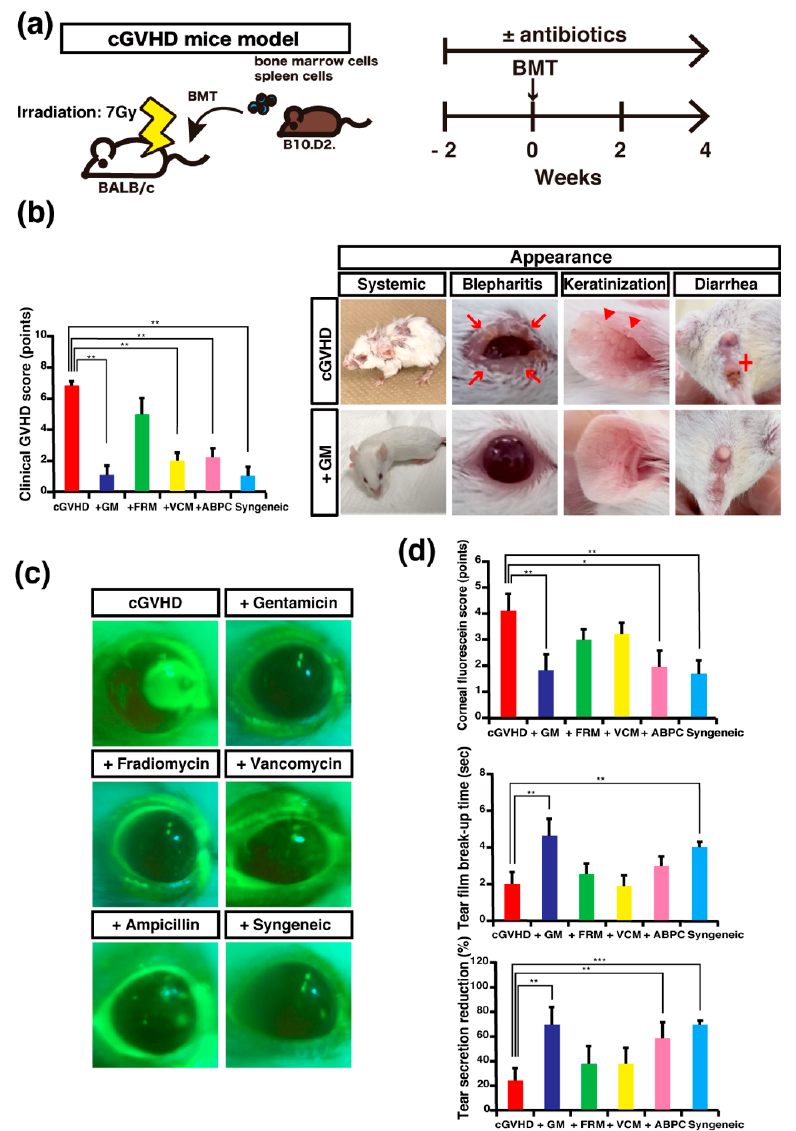
Figure 1. Systemic and ocular clinical phenotypes of antibiotic-treated chronic graft-versus-host disease (cGVHD) mice: ( A ) scheme of allogeneic bone marrow transplantation (BMT), and the experimental treatment protocol using antibiotics; ( B ) clinical GVHD scores of cGVHD mice treated with antibiotics, non-treated control mice, and syngeneic control mice (left) ( n = 5 per group). GM, gentamicin; FRM, fradiomycin; VCM, vancomycin; ABPC, ampicillin. Data are presented as mean ± SEM. * p <0.05, unpaired Student’s t -test for non-treated cGVHD mice versus antibiotic-treated or syngeneic control mice. Representative images of non-treated and GM-treated cGVHD mice (+GM) (right). The non-treated cGVHD mice exhibited signs of cGVHD, such as blepharitis (red arrows), keratinization (red arrowheads), and diarrhea (red cross); ( C ), ( D ) ocular examinations of cGVHD mice treated with antibiotics, non-treated control mice, and syngeneic control mice. Representative images of corneal fluorescein staining ( C ). Corneal fluorescein score (upper right), tear-film breakup time (middle right), and tear secretion reduction (lower right). Data are presented as mean ± SEM. * p <0.05, ** p <0.01, *** p <0.001, unpaired Student’s t -test for non-treated cGVHD mice versus antibiotic-treated or syngeneic control mice. ( A–D ), Data are representative of at least two independent experiments ( n = 5 per group).